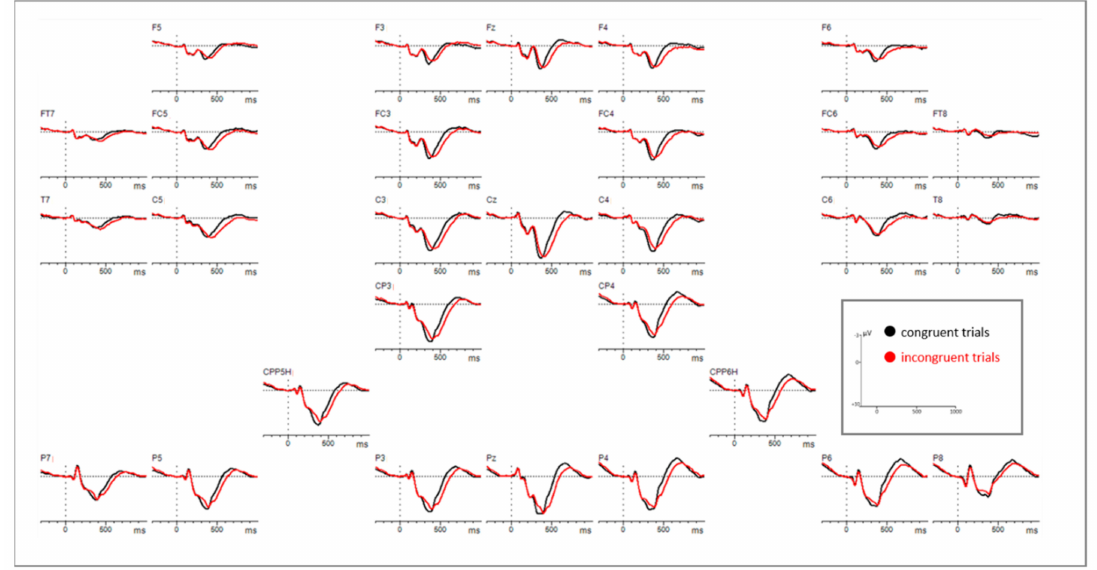
Figure A2. Grid view of patients ( n = 28), showing the processing of congruent versus incongruent stimuli on all